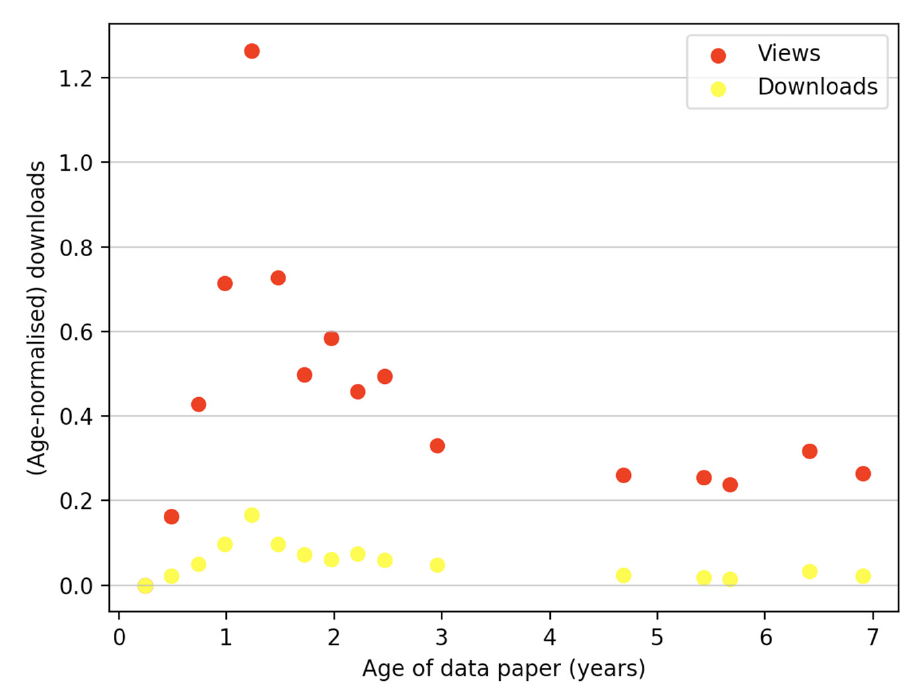
Figure A5. JOHD/RDJ data papers: average downloads and views over time (3-month ranges).